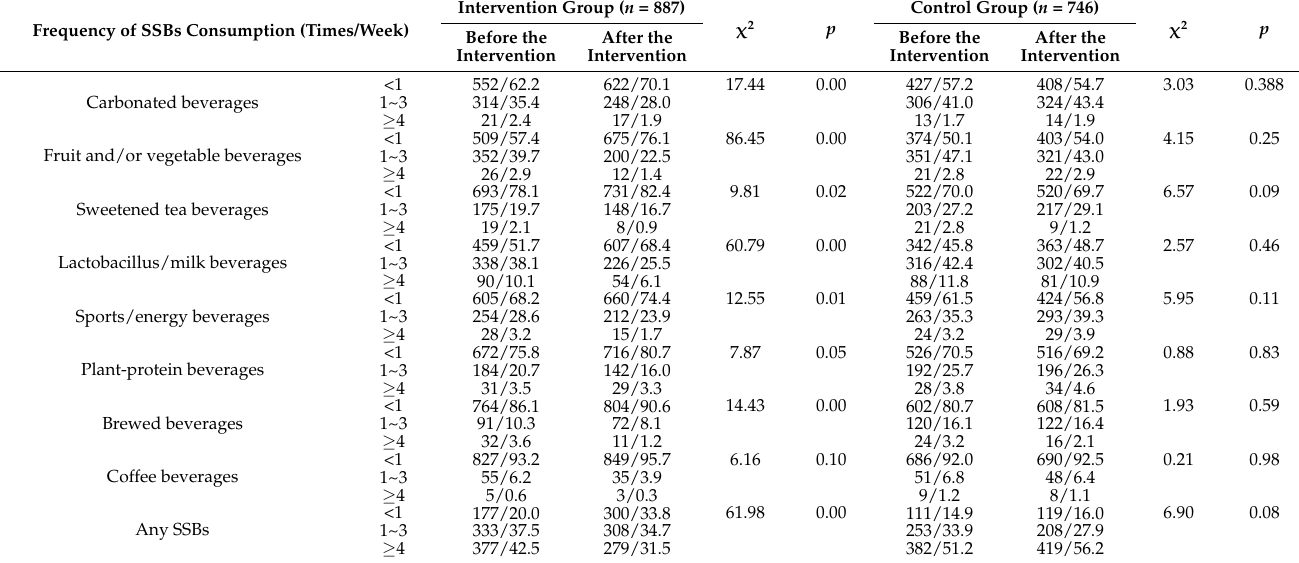
Table 5. Frequency distribution of sugar-sweetened beverages (SSBs) consumption before and after intervention (N/%).